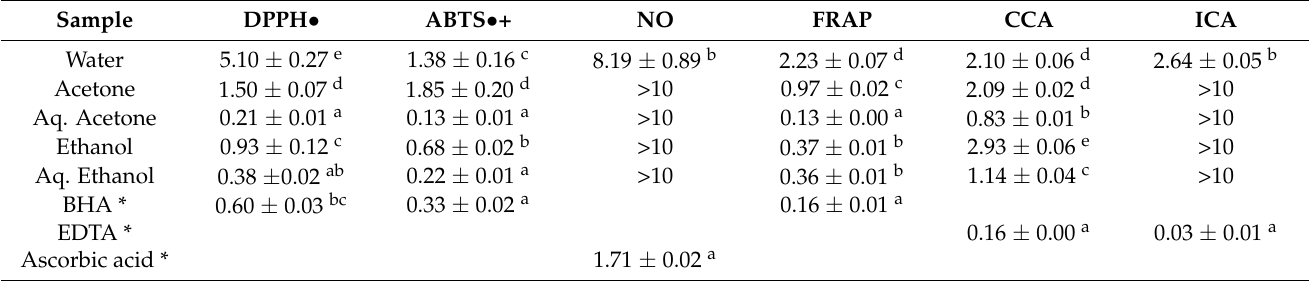
Table 3. Antioxidant activity (EC 50 values, mg/mL) of extracts from Cladium mariscus (sawgrass) seeds: radical scavenging on DPPH • , ABTS • +, and NO radicals, ferric reducing antioxidant power (FRAP) and metal-chelating activities on copper (CCA) and iron